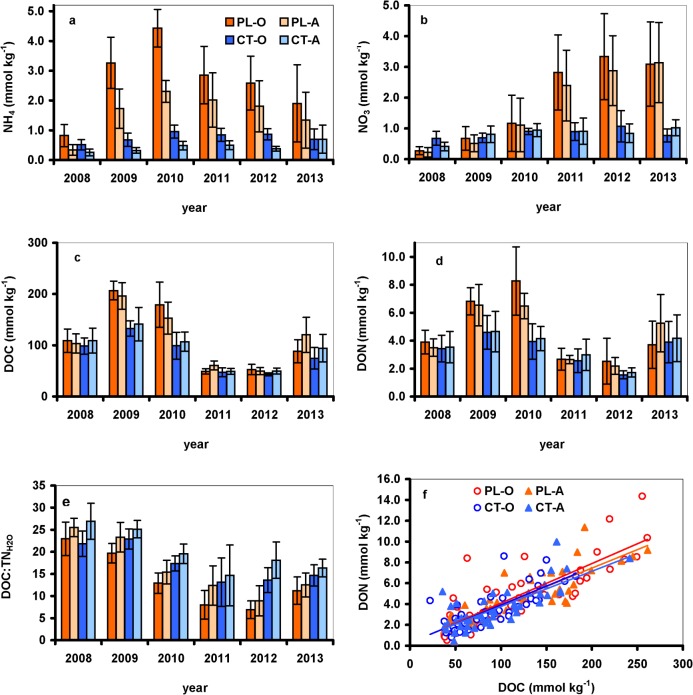
Annual average (n = 8–9 for each year) concentrations of (a) NH4, (b) NO3, (c) DOC, (d) dissolved organic N (DON), (e) annual average molar DOC:TNH2O ratios, and (f) relationship between DOC and DON concentrations in water extracts from the O and A soil horizons at the Plešné (PL) and Čertovo (CT) plots.Data on concentrations from 2008–2010 are from Kaňa et al. (2013). Vertical bars denote 95% confidence intervals. Lines in Fig 1f represent linear regressions (PL-O: y = 0.04x + 0.27, R
2 = 0.70; PL-A: y = 0.04x + 0.35, R
2 = 0.75; CT-O: y = 0.04x + 0.29, R
2 = 0.58; CT-A: y = 0.03x + 0.38, R
2 = 0.68).